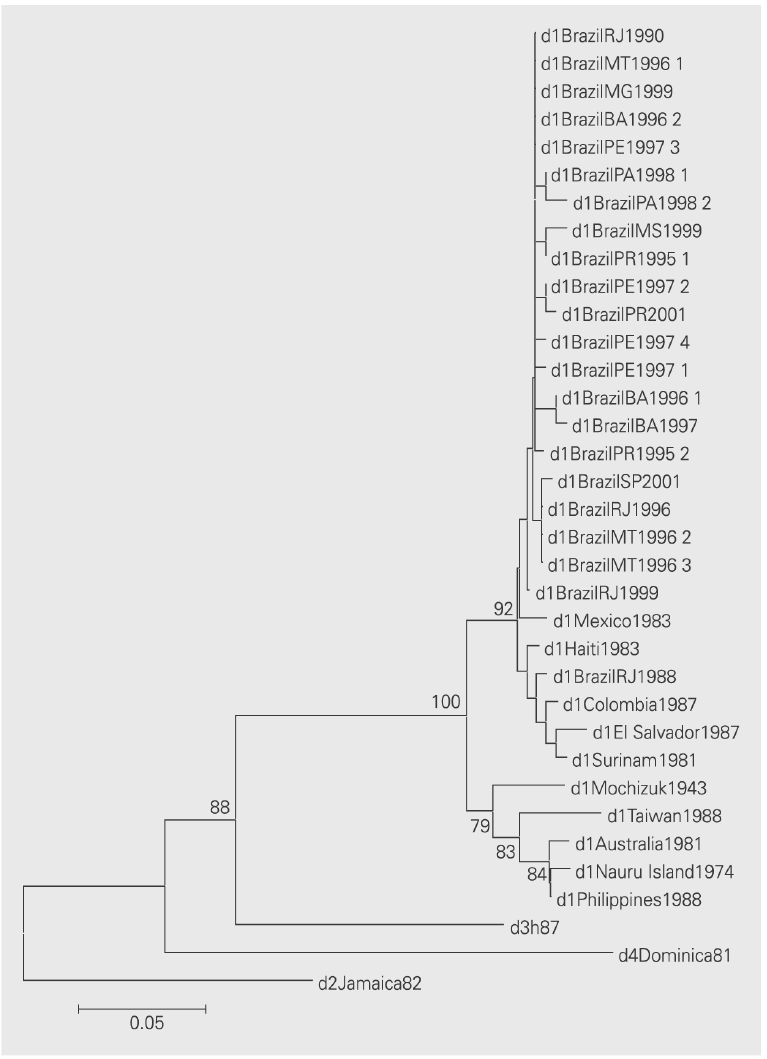
Figure 1. Phylogenetic relationships among dengue-1 (DEN-1) viruses. Phylogenetic tree generated by neighbor-joining analysis of nucleotide sequences from the E/NS1 junction of 32 strains of DEN-1 and representatives of serotypes 2, 3 and 4. Viruses are listed by strain abbreviation for state and year of isolation (see Table 1). Horizontal branch lengths are drawn to scale. Bootstrap values (500 replicates) are shown for some key nodes that connect the genotypic groups of